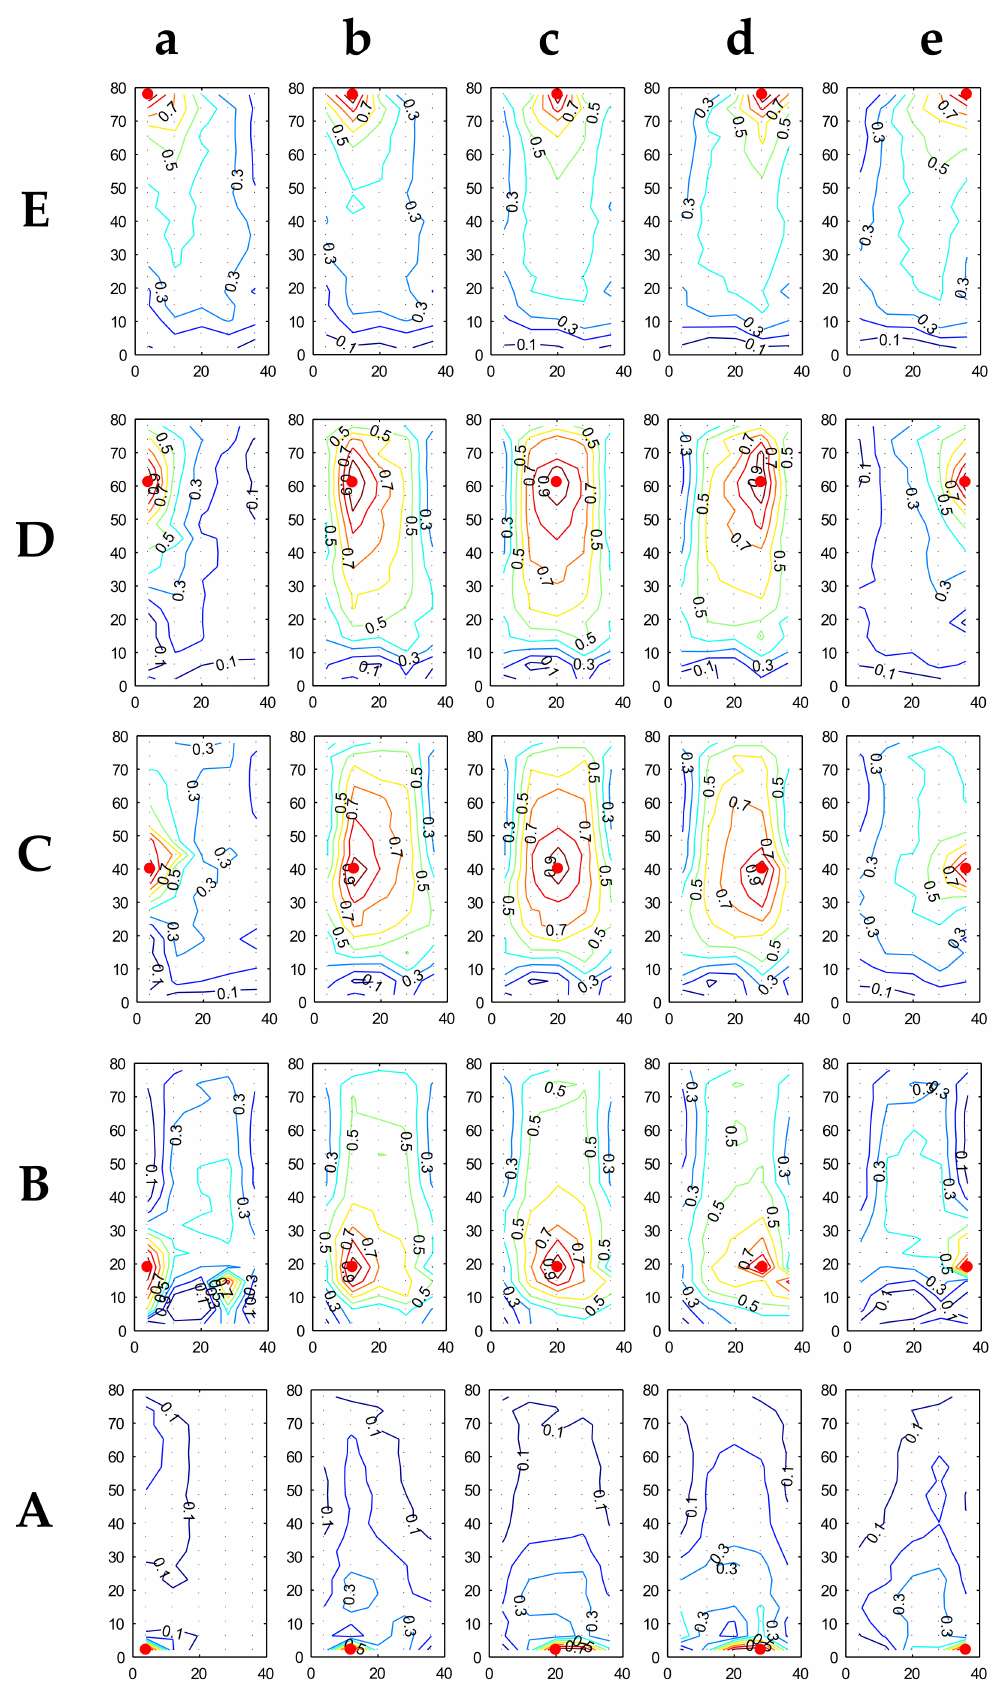
Figure 6. Correlation coefficient trend for RLF at 0 ◦ . Color bar as in Figure